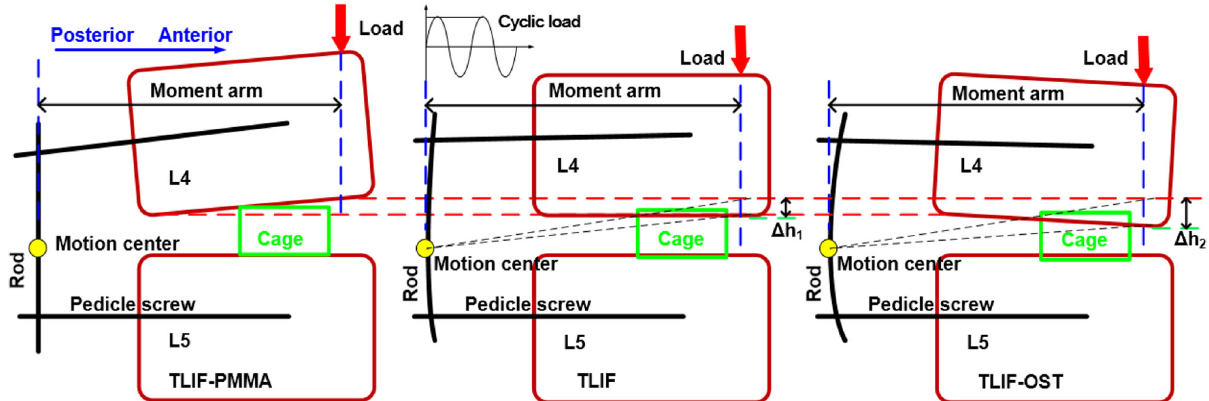
Fig. 9 The schematic diagrams to illustrate the load-transferring mechanism of the TLIF-PMMA, TLIF, and TLIF-OST models at the fused (L4- L5)